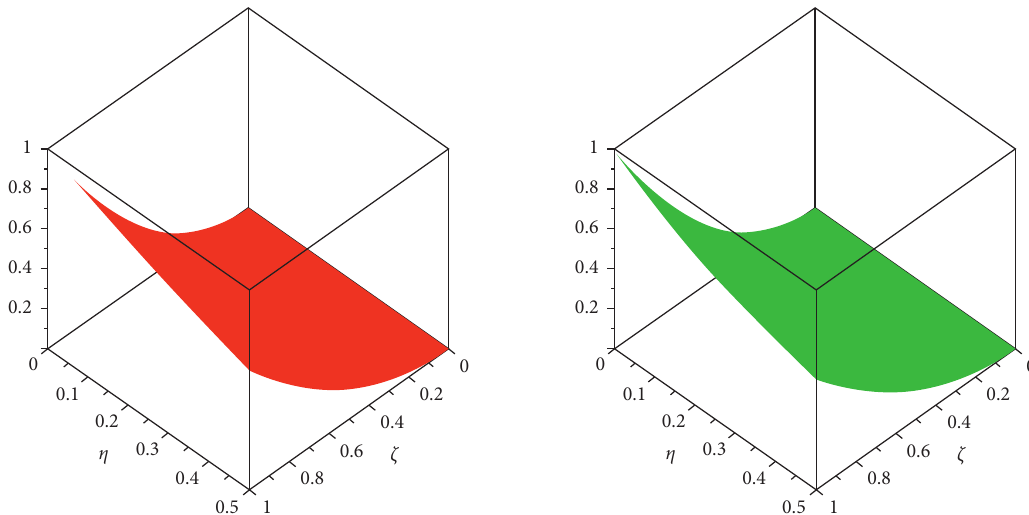
Figure 7: The approximate result graph of problem 4.3, at δ � 1 and 0.8.